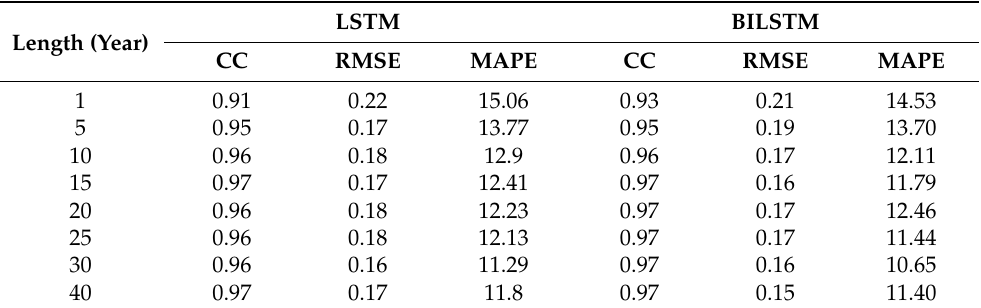
Table 6. Sensitivity of the training data length with the accuracy of the prediction using LSTM and BiLSTM.